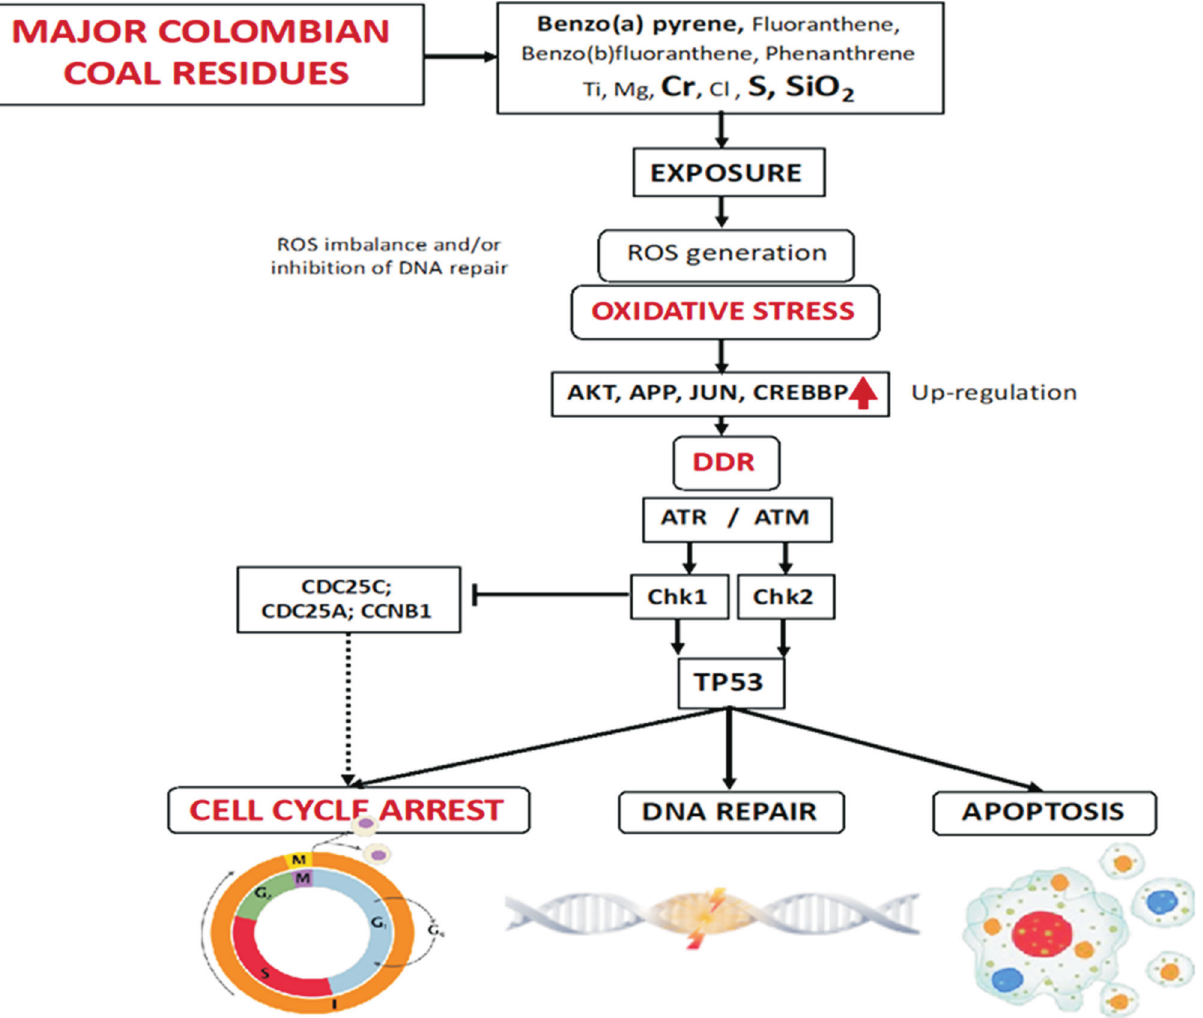
Figure 11 - Molecular model illustrating how major coal residues potentially affect cell cycle progression: Exposure to major coal residues, such as benzo[a]pyrene,fluoranthene,benzo[b]fluoranthene,phenanthrene,Ti,Mg,Cr,Cl,S,andSiO 2 ,cangenerateROSviaseveralpathways(e.g.,Fenton-likereac- tions). The ROS imbalance and/or inhibition of the DNA repair process can lead to oxidative stress and the upregulation of several proteins associated with the oxidative response (AKT, APP, JUN and CREBBP) which are also involved in the control of the cell cycle. DNA and protein damage caused by the oxidative damage triggers DNA damage response mechanisms (DDR), including the protein kinase cascades ATM-Chk2/ATR-Chk1, which may result in cell cycle ar- rest.OxidativestresscanalsoinducecellcyclearrestthroughthedegradationofCDC25CviatheChk1proteinkinase-dependentpathway.ATRphosphorylates andactivatesChk1,whichinturn,phosphorylatesandinhibitsCdc25phosphatases.Cdc25inhibitionendsupcausingcellcyclearrest.Cdc25Aphosphorylation byChk1triggersitsdegradationinaubiquitin/proteasome-dependentmanner.BothkinasesphosphorylateTP53.InresponsetoDNAdamage,theactivationof TP53 activates the expression of numerous genes involved in cell cycle arrest, DNA repair, apoptosis, and many other